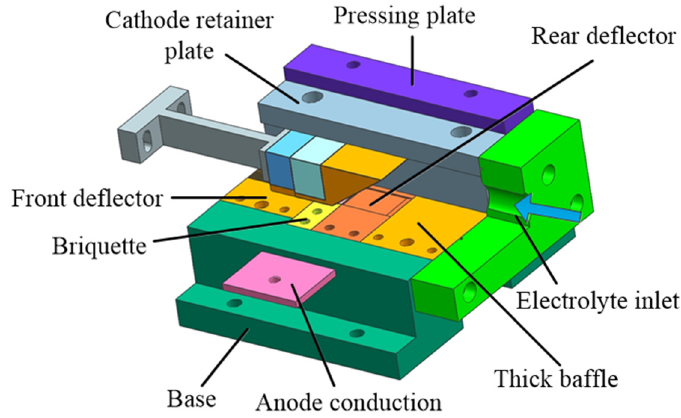
Figure 10. Fixture assembly model.